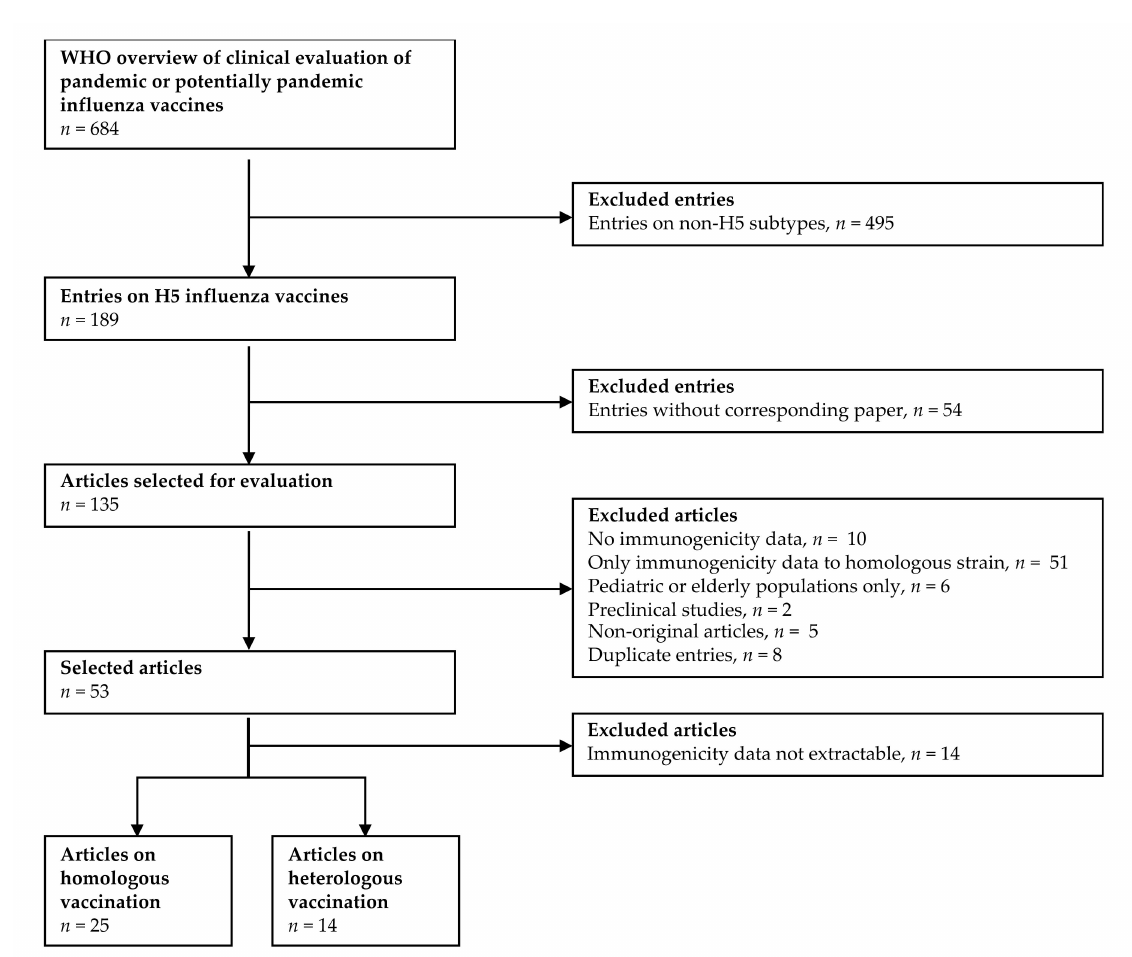
Figure 1. Flowchart summarizing the data selection in present analysis. The WHO overview of clinical evaluation of pandemic or potentially pandemic influenza vaccines [15] was used as a starting point for data